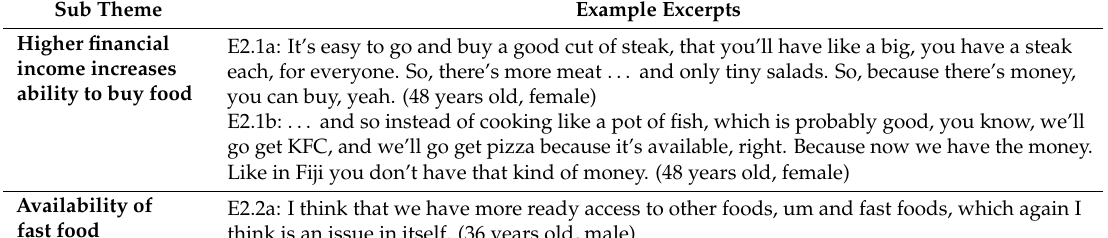
Table 3. Excerpts related to culturally specific barriers to preventing or controlling